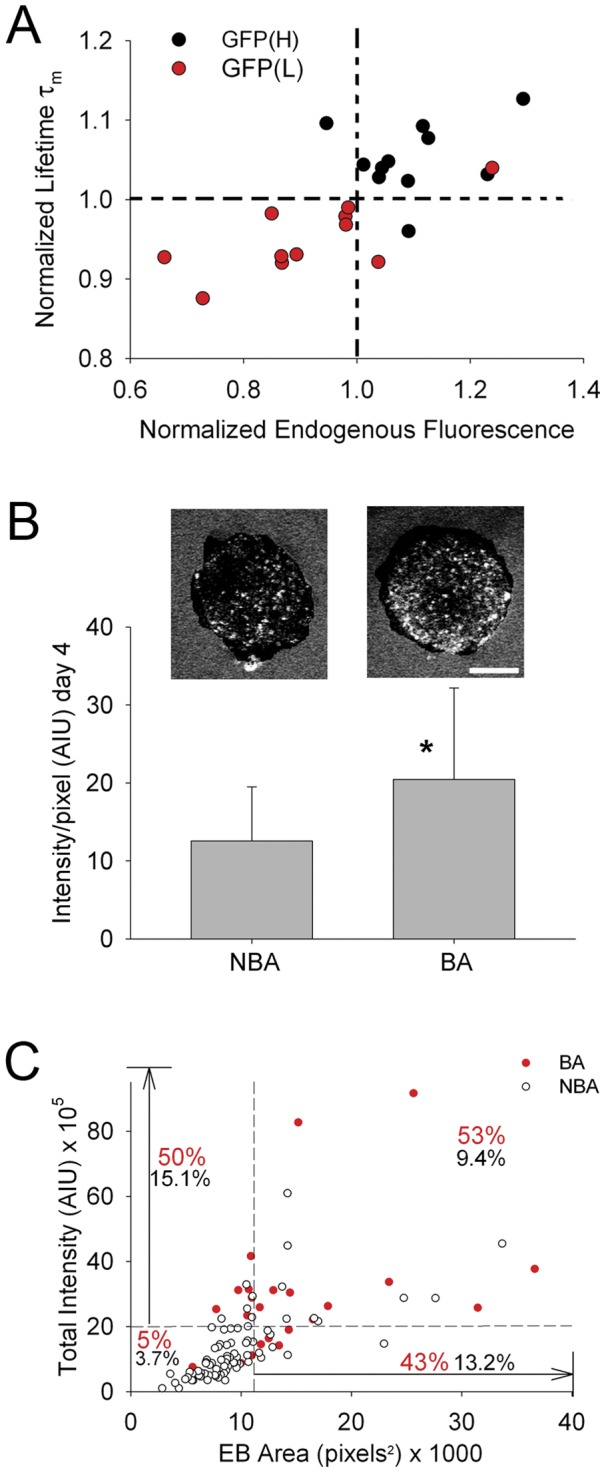
Potential utilization of endogenous fluorescence parameters.A. Scatter plot showing relationship between fluorescence lifetime (τm), endogenous fluorescence, and Oct4-GFP intensity category. Each circle represents one cell. Dotted lines indicate arbitrary threshold to illustrate the effect of segregating a population of cells based on two endogenous fluorescence parameters. B. Quantitation comparing the endogenous fluorescence intensity (background subtracted intensity per pixel of EB brightfield area) of hEBs on day 4 of EB formation, segregated by those that subsequently formed beating areas (BA) and those which did not (NBA). * indicates significant difference (P≤0.001, Mann-Whitney). Images above bars show MPLSM single optical sections of hEBs, using 780 nm excitation, on day 4 after hEB formation prior to attachment, to show background subtracted endogenous fluorescence intensity. hEB on right subsequently develops a beating area (BA) while the one on the left does not (NBA). Scale bar = 100 µm. C. Assessment of the putative enrichment for subsequent developmental of beating areas (day 24) based on fluorescence intensity on day 4. Graph shows the proportion of hEBs that developed beating area (filled red circles) when selected from the 30% of EBs that have the highest fluorescence intensity at day 4 (above horizontal dotted line), largest area (to right of vertical dotted line) or both (upper right quadrant) compared to those in the lower 70% (below or to left of dotted lines for intensity or area, respectively). Open circles represent EBs that did not develop beating areas. Red numbers indicate percentage of EBs with beating areas in that category (e.g. upper 30% of intensity or upper 30% of area) of the total number of EBs within that category while black numbers indicate the percentage of EBs with beating areas in that category of the total number of EBs examined (n = 106 EBs).